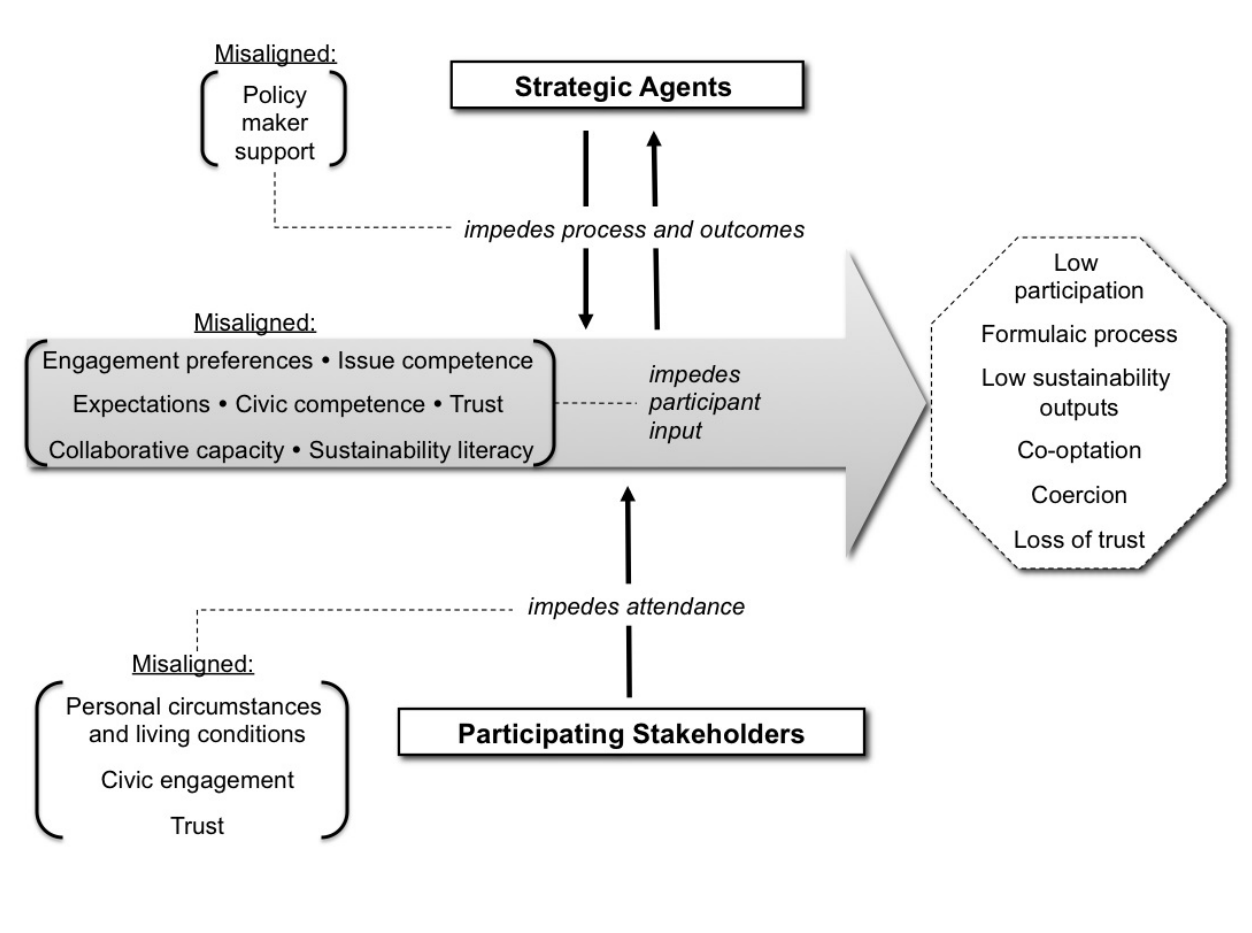
Figure 2. Misalignments mapped onto the public participation